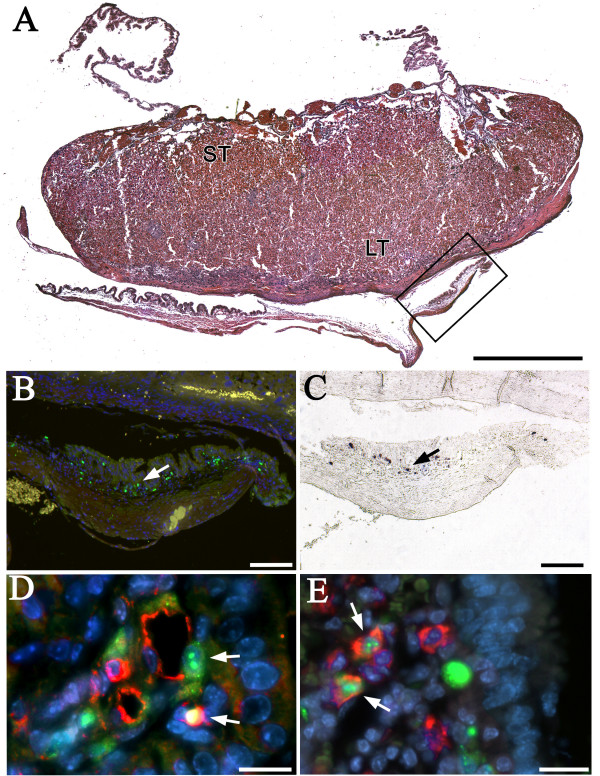
Congenital MCMV infection in E18 fetal membranes. Pregnant SCID mice were injected with 103 PFU of MCMV at E4. A: H&E staining of an E18 SCID mouse placenta with extraembryonic membranes. ST, spongiotrophoblastic zone; LT, labyrinthine zone; visceral yolk sac in box. B: Anti-MCMV immunostaining (green; arrow) for viral antigens in the mesodermal layer of the visceral yolk sac boxed in (A). C: In situ hybridization (purple; arrow) for MCMV RNA in the mesodermal layer of the visceral yolk sac boxed in (A). D: Anti-MCMV immunostaining (green) in endothelial cells (anti-CD31+: red) in the walls of blood vessels (arrows) within the visceral yolk sac of an E18 embryo. E: Anti-MCMV immunostaining (green, arrows) within macrophages (anti-F4/80: red) in the visceral yolk sac mesoderm of an E18 embryo. A,D&E: Bisbenzimide nuclear stain (blue). A: Bar = 1 mm; B&C: Bars = 100 μm, D&E: Bars = 20 μm.